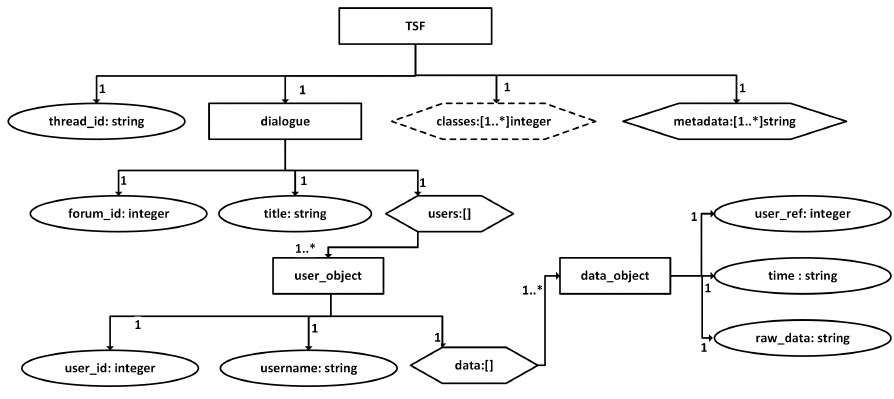
Figure 6. TSF Schema.